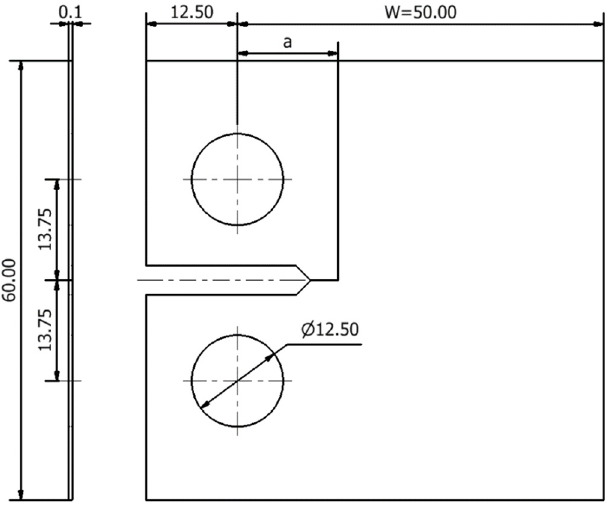
Figure 2. Compact tension specimen modelled for AA2024-T351, with dimensions in mm.